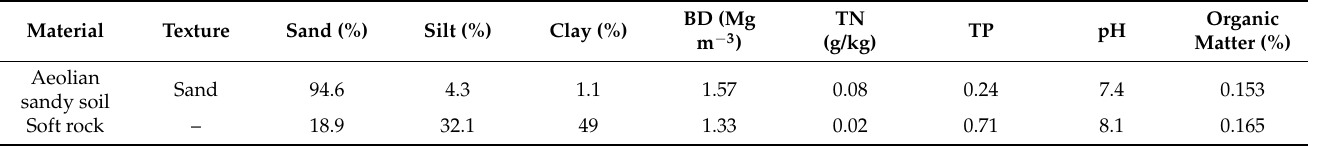
Table 1. Primary physical properties of sand soil and soft rock in the study